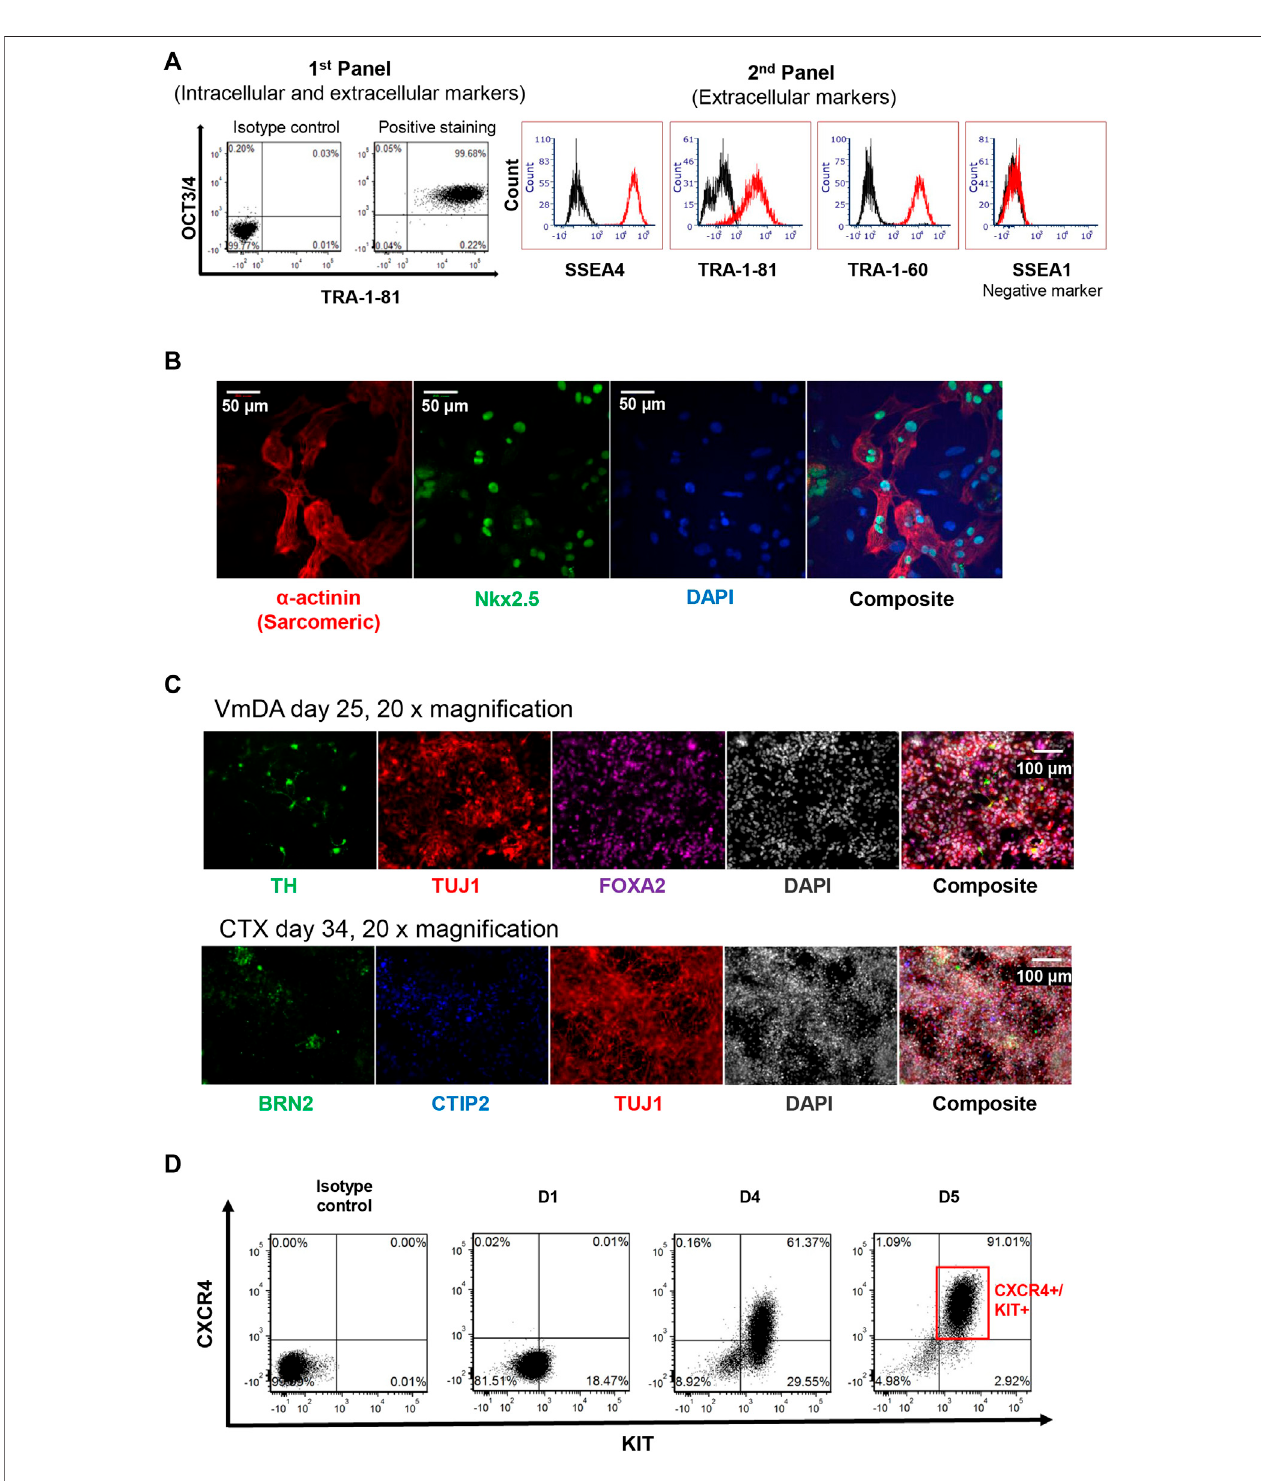
FIGURE 3 | Assessment of iPSC pluripotency. (A) 2D plot of stemness markers used for assessing putative iPSC, including two panels used. (B) Immuno fl uorescencestainingofcardiomyocytesderivedfromiPSC.Nkx2.5showningreen, α -actinin(Sarcomeric)showninred,DAP1inblue. (C) Immuno fl uorescence staining of neuronal differentiation toward ventral midbrain dopamine (VmDA) neurons and cortical neurons from iPSC. TH and BRN2 shown in green, TUJ1 shown in red, FOXA2 shown in purple. CTIP2 shown in blue, DAPI shown in grayscale. (D) 2D plot showing 90% de fi nitive endoderm cells could be obtained from iPSC cell line on day